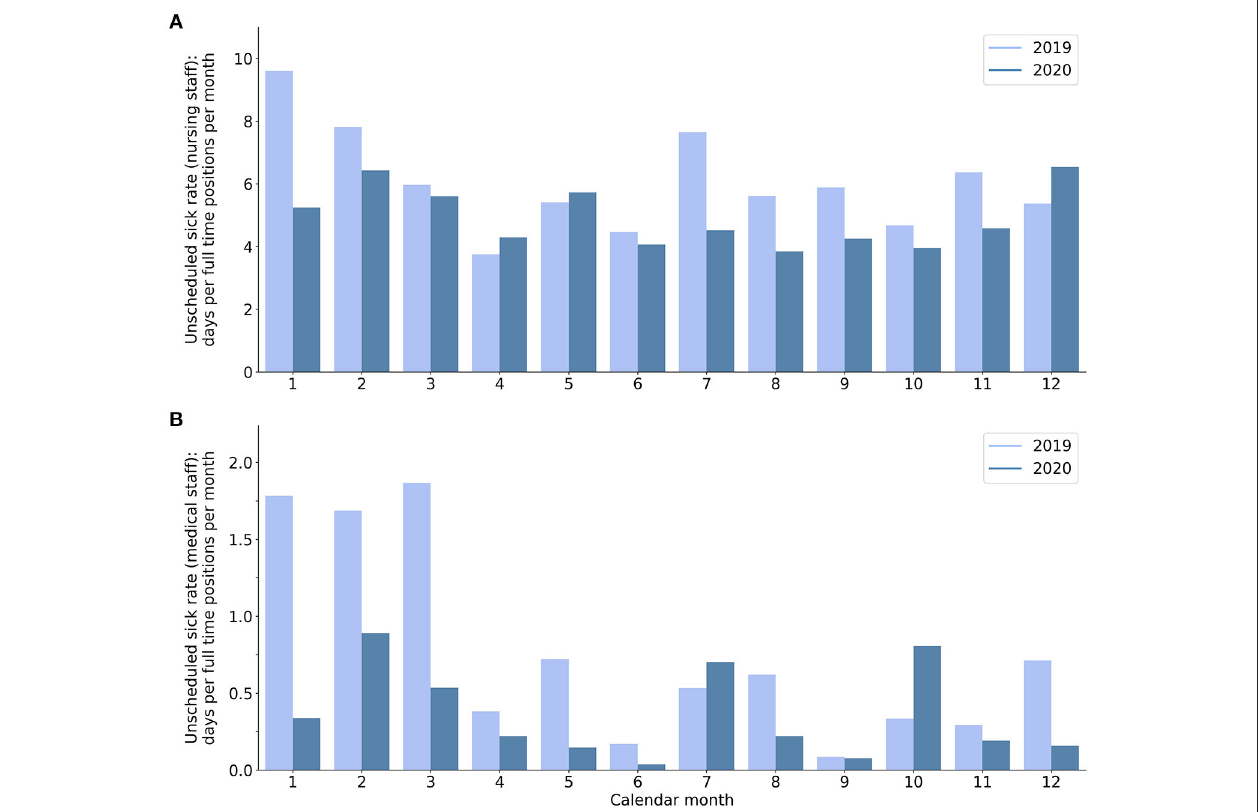
FIGURE 2 | Unscheduled sick rate of (A) nursing staff and (B) medical staff at BCH departments caring for SARS-CoV-2 positive patients: days per full-time position per calendar month in 2019 (bright bars) and 2020 (dark